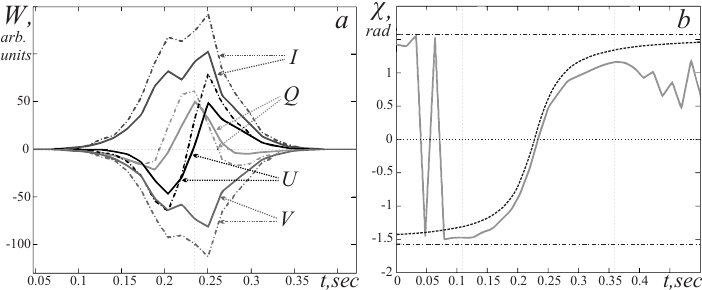
Fig. 3. Panel (a) shows the Stokes parameters and panel (b) – PA calculated from these parameters: χ = 1 / 2 arg( Q + iU ). Three anomalously intensive pulses of PSR B0809+74 that have been registered